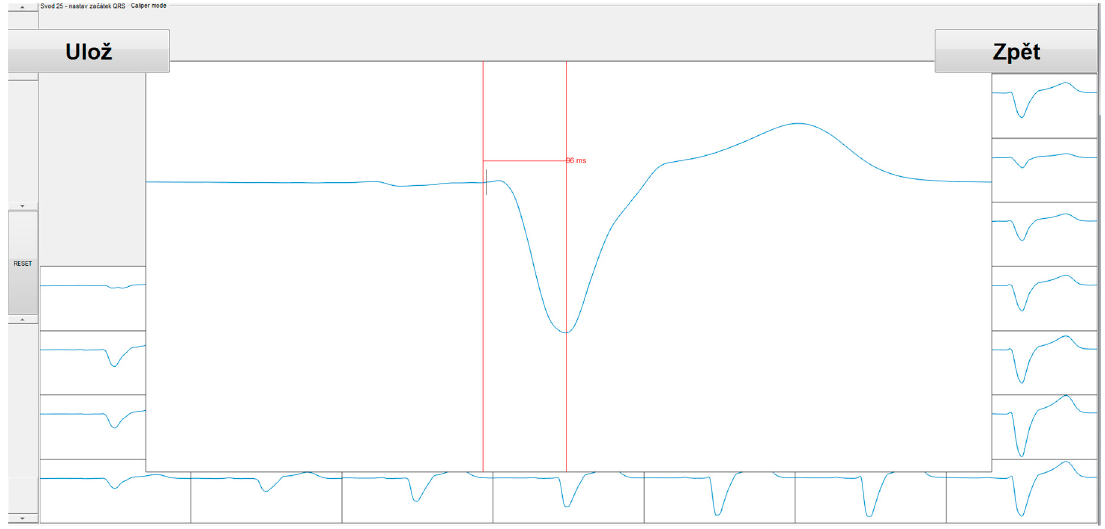
Figure 6. An example of the window for manual delineation with caliper. The button “Uložit” represents the save button and the button “Zp ě t” represents operation undo